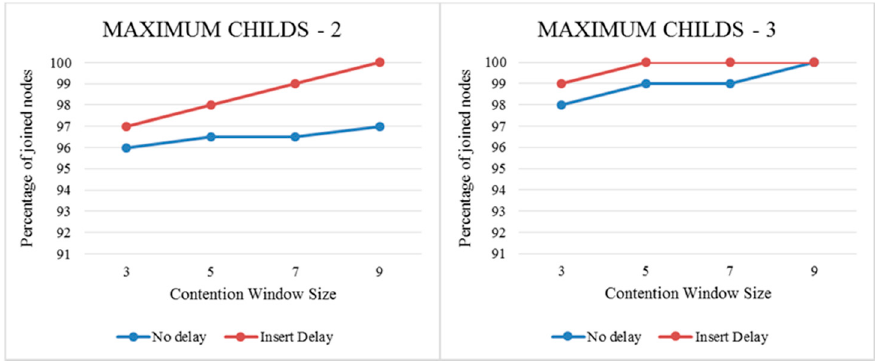
Figure 15. Percentage of joined nodes during the NCP. Table 3. The number of timeslots used in the experiment scenario.